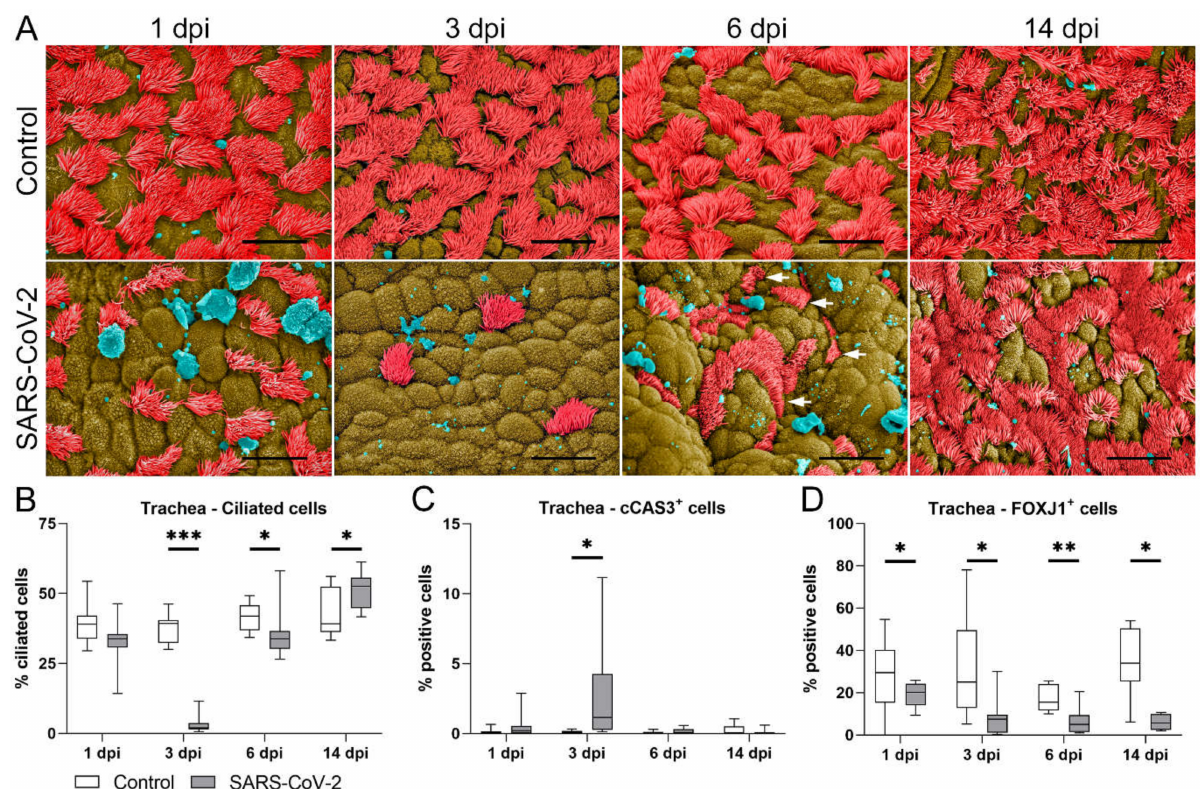
Figure 2. SARS-CoV-2 causes transient ciliary loss followed by cilia regeneration within two weeks, and this is accompanied by the prolonged reduction of FOXJ1 + cells. ( A ) Scanning electron